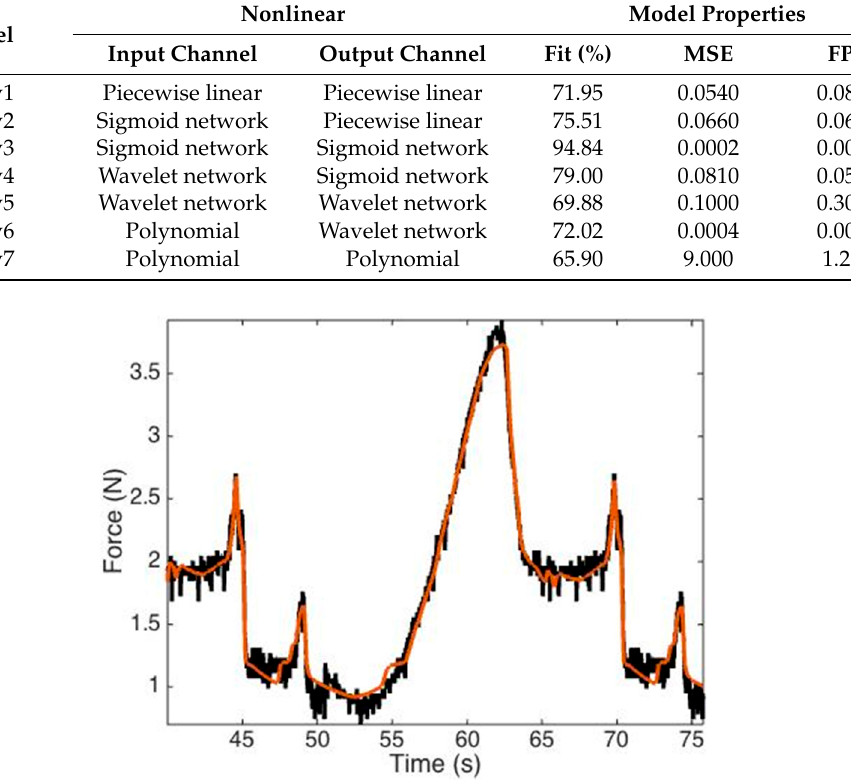
Table 3. Nonlinear input and output channel estimators assessed in H-W modeling.